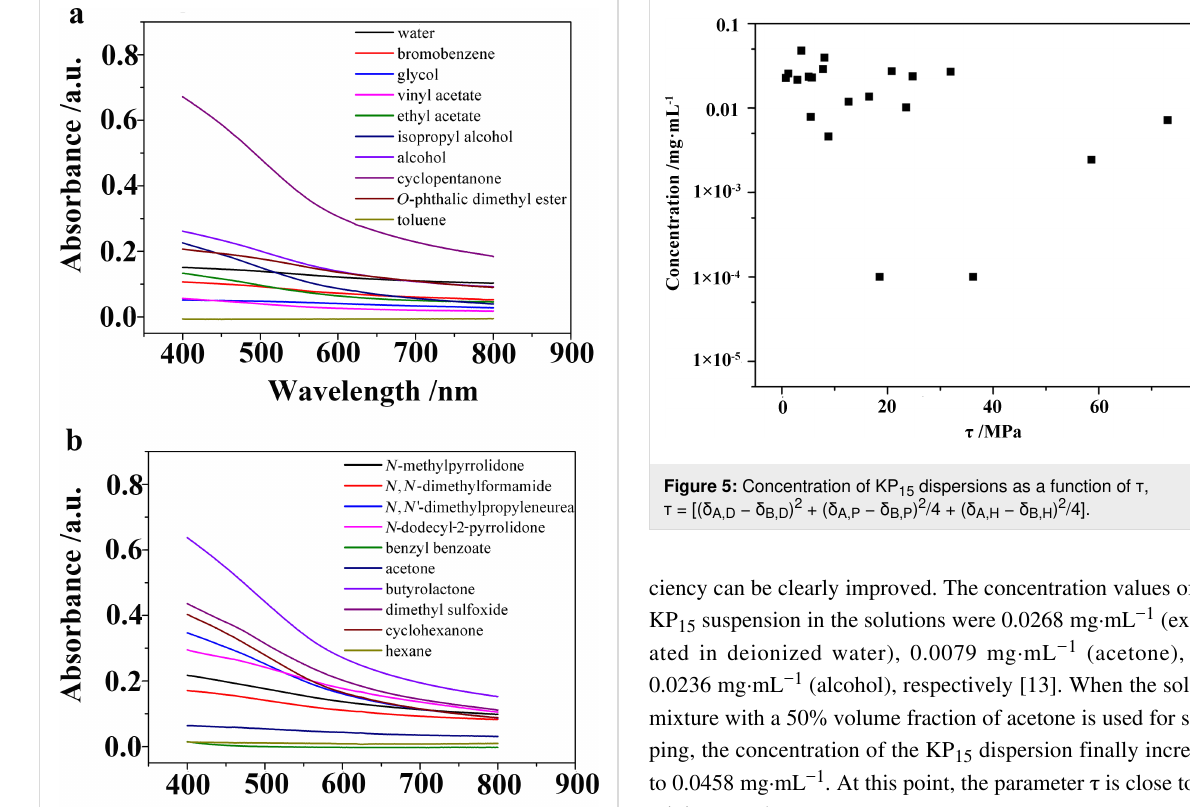
where ϕ i ,comp is the volume fraction of the corresponding sol- vent and δ i ,comp is the HSPs of the solvent. The concentration of the KP 15 dispersion can be measured by the Lambert–Beer law (Equation 3). As shown in Figure 6a, by tuning the volume frac- tion of acetone in the mixed solution, the HSPs of the mixed solution can be close to those of KP 15 , and the exfoliation effi-